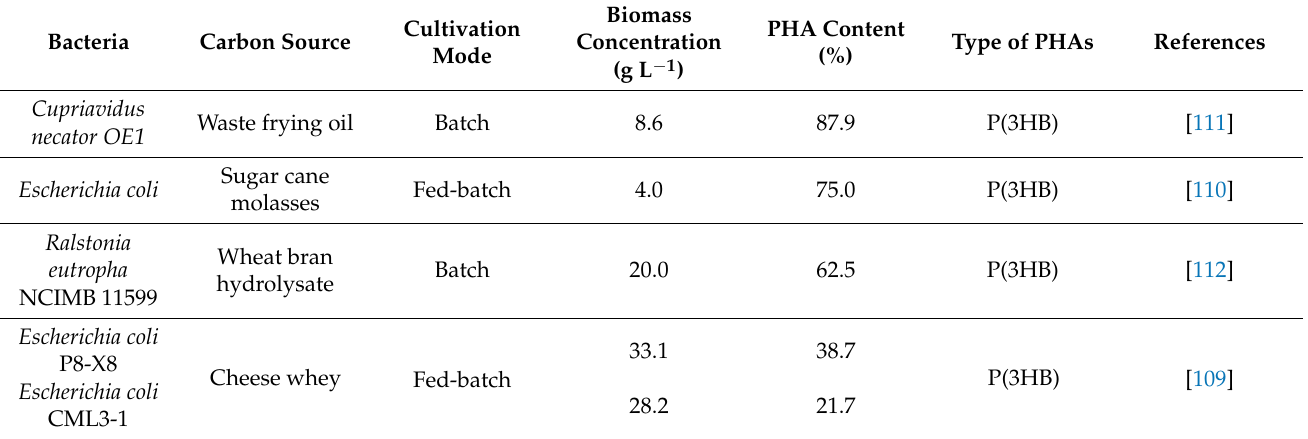
Table 4. An overview of PHAs production by genetically modified bacteria grown on waste carbon sources.